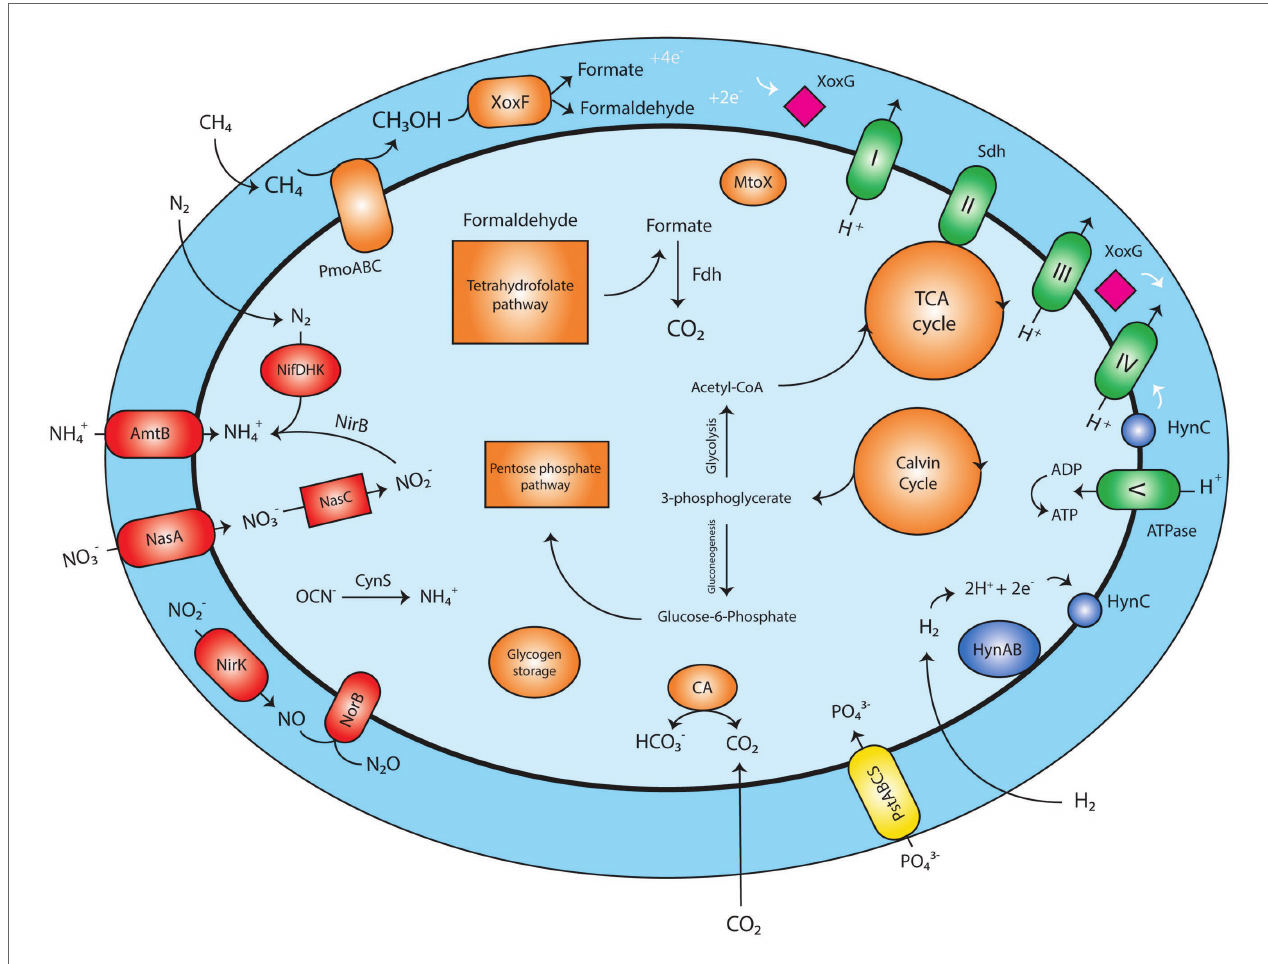
FIGURE 2 | Schematic reconstruction of Methylobacterium thermophilum AP8 metabolism. Red, nitrogen metabolism; Orange, carbon metabolism; Green, respiratory chain; Yellow, phosphate transporter; Blue: hydrogenase; Pink, cytochrome; PmoABC, particulate methane monooxygenase; XoxF, methanol dehydrogenase; XoxG, cytochrome C L ; Fdh, formate dehydrogenase; MtoX, methanethiol oxidase; CA, carbonic anhydrase; Sdh, succinate dehydrogenase; PstABCS, phosphate transport system; HynABC, small, large, and cytochrome b subunit of the group 1b [NiFe] hydrogenase; NifDHK, nitrogenase; AmtB, NH3/ NH4+ transporter; NasA, nitrate transporter; NasC, assimilatory nitrate reductase; NirK, nitrite reductase; NorB, nitric oxide oxidoreductase; CynS, cyanate hydratase. A list of all annotated genes can be found in Supplementary Table S2